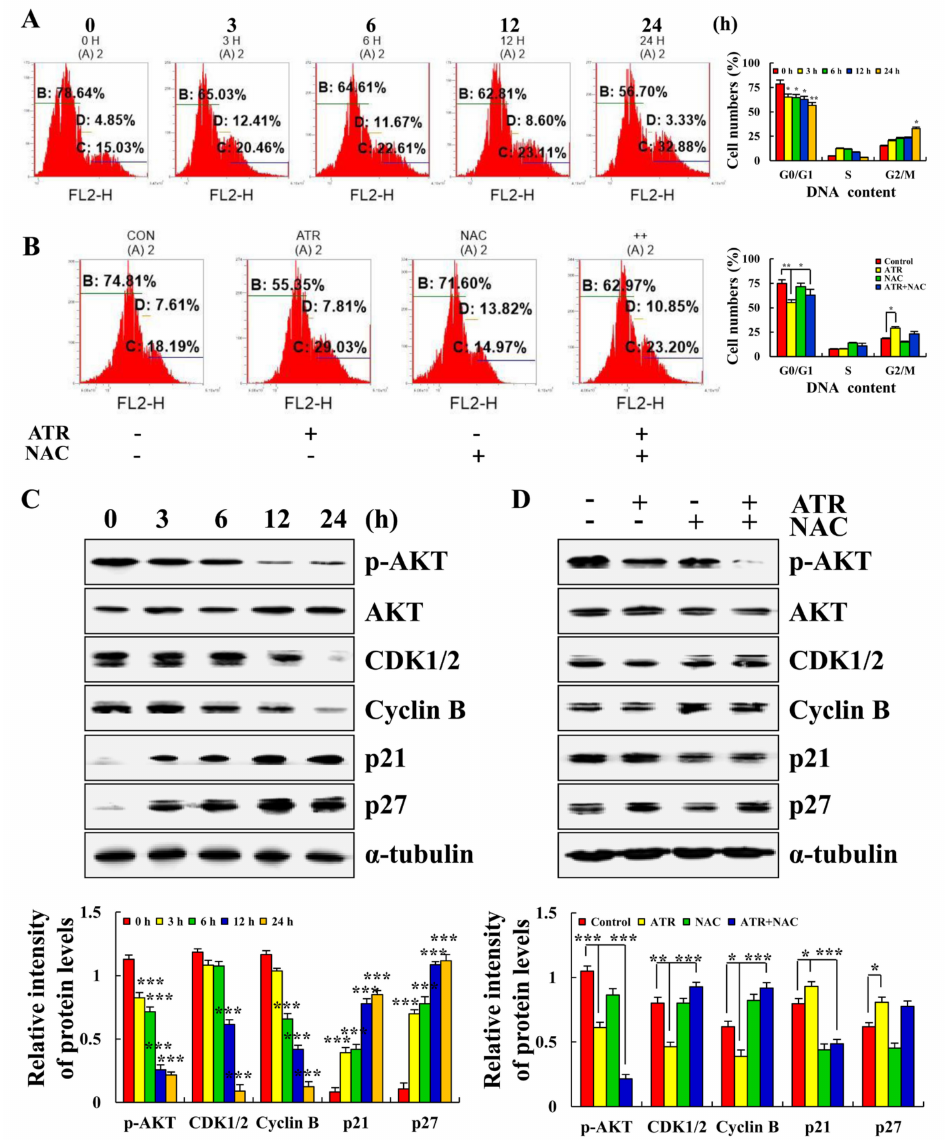
Figure 5. Effects of ATR on cell cycle arrest of A549 cells. A549 cells treated with 38 µ M ATR for 3, 6, 12, and 24 h. ( A ) RNase and PI staining, flow cytometry analysis of cell cycle. ( C ) Protein expression levels of p-AKT, CDK1/2, Cyclin B, p21, and p27 detected by Western blot analysis. * p < 0.05, ** p < 0.01 and *** p < 0.001 vs. 0 h. A549 cells treated with 38 µ M ATR and/or 10 mM NAC for 24 h. ( B ) Rnase and PI staining, flow cytometry analysis of cell cycle. ( D ) Protein expression levels of p-AKT, CDK1/2, Cyclin B, p21, and p27 detected by Western blot analysis. α -Tubulin used as internal reference. * p < 0.05, ** p < 0.01 and *** p < 0.001 vs. control or ATR + NAC